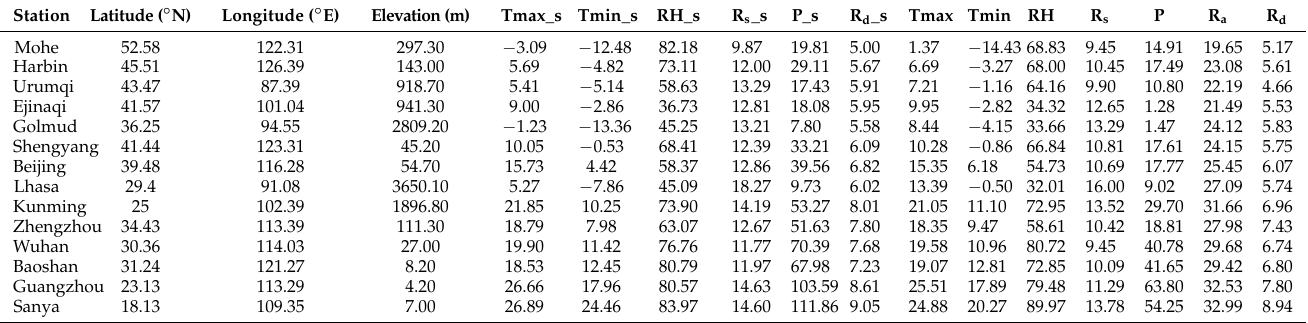
Figure 1. Distribution of the 14 stations with R d measurements in China. Table 1. Summary of geographical location and meteorological data for 14 stations in China during 2011–2015.